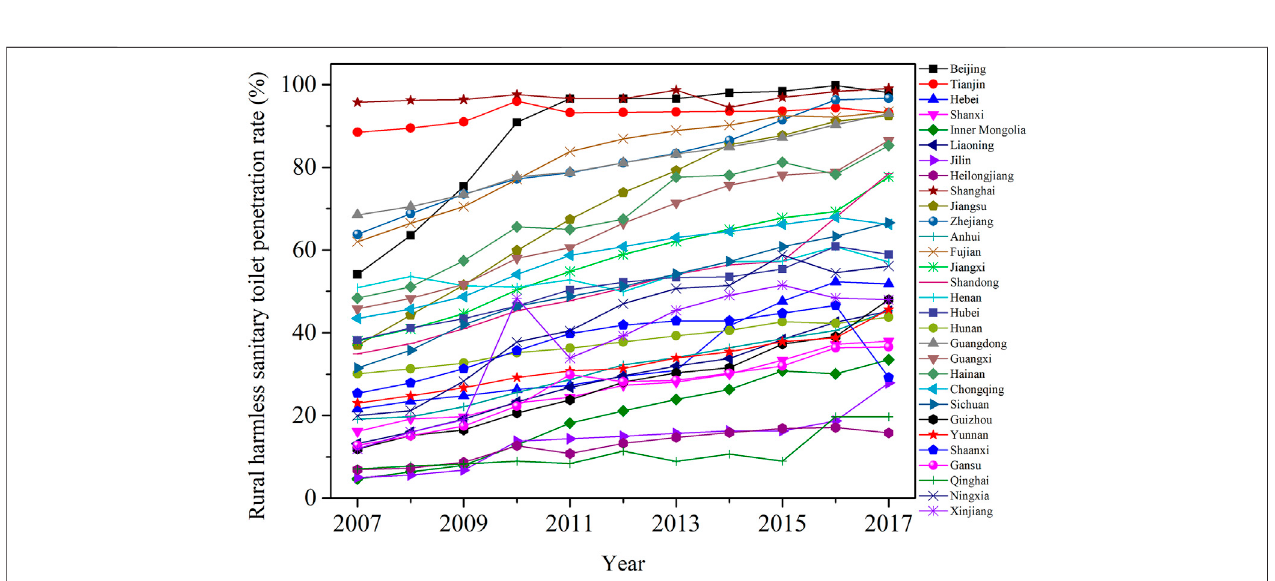
FIGURE 4 | Process of change in the penetration rate of rural harmless sanitary toilets (RHST) in 30 regions of China from 2007 to 2017.